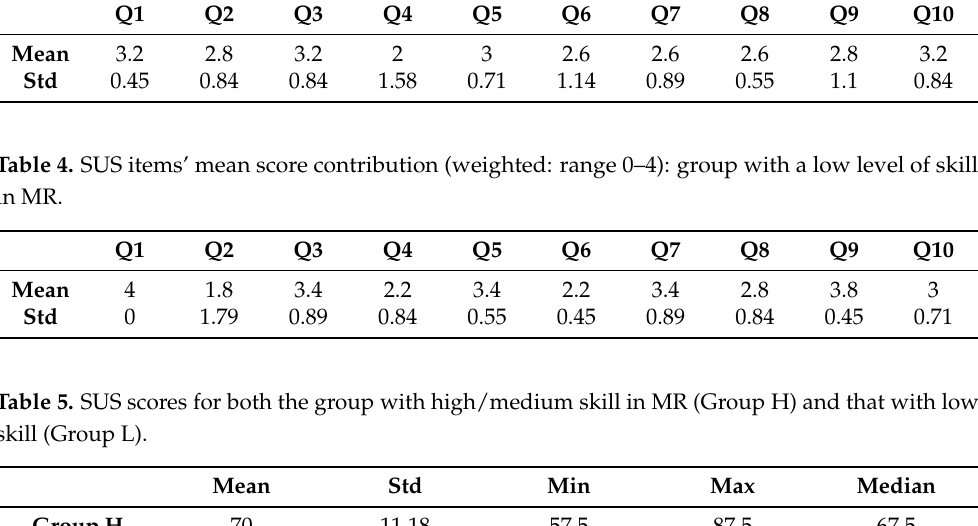
Table 3. SUS items’ mean score contributions (weighted: range 0–4): group with a high/medium level of skill in MR. Q1